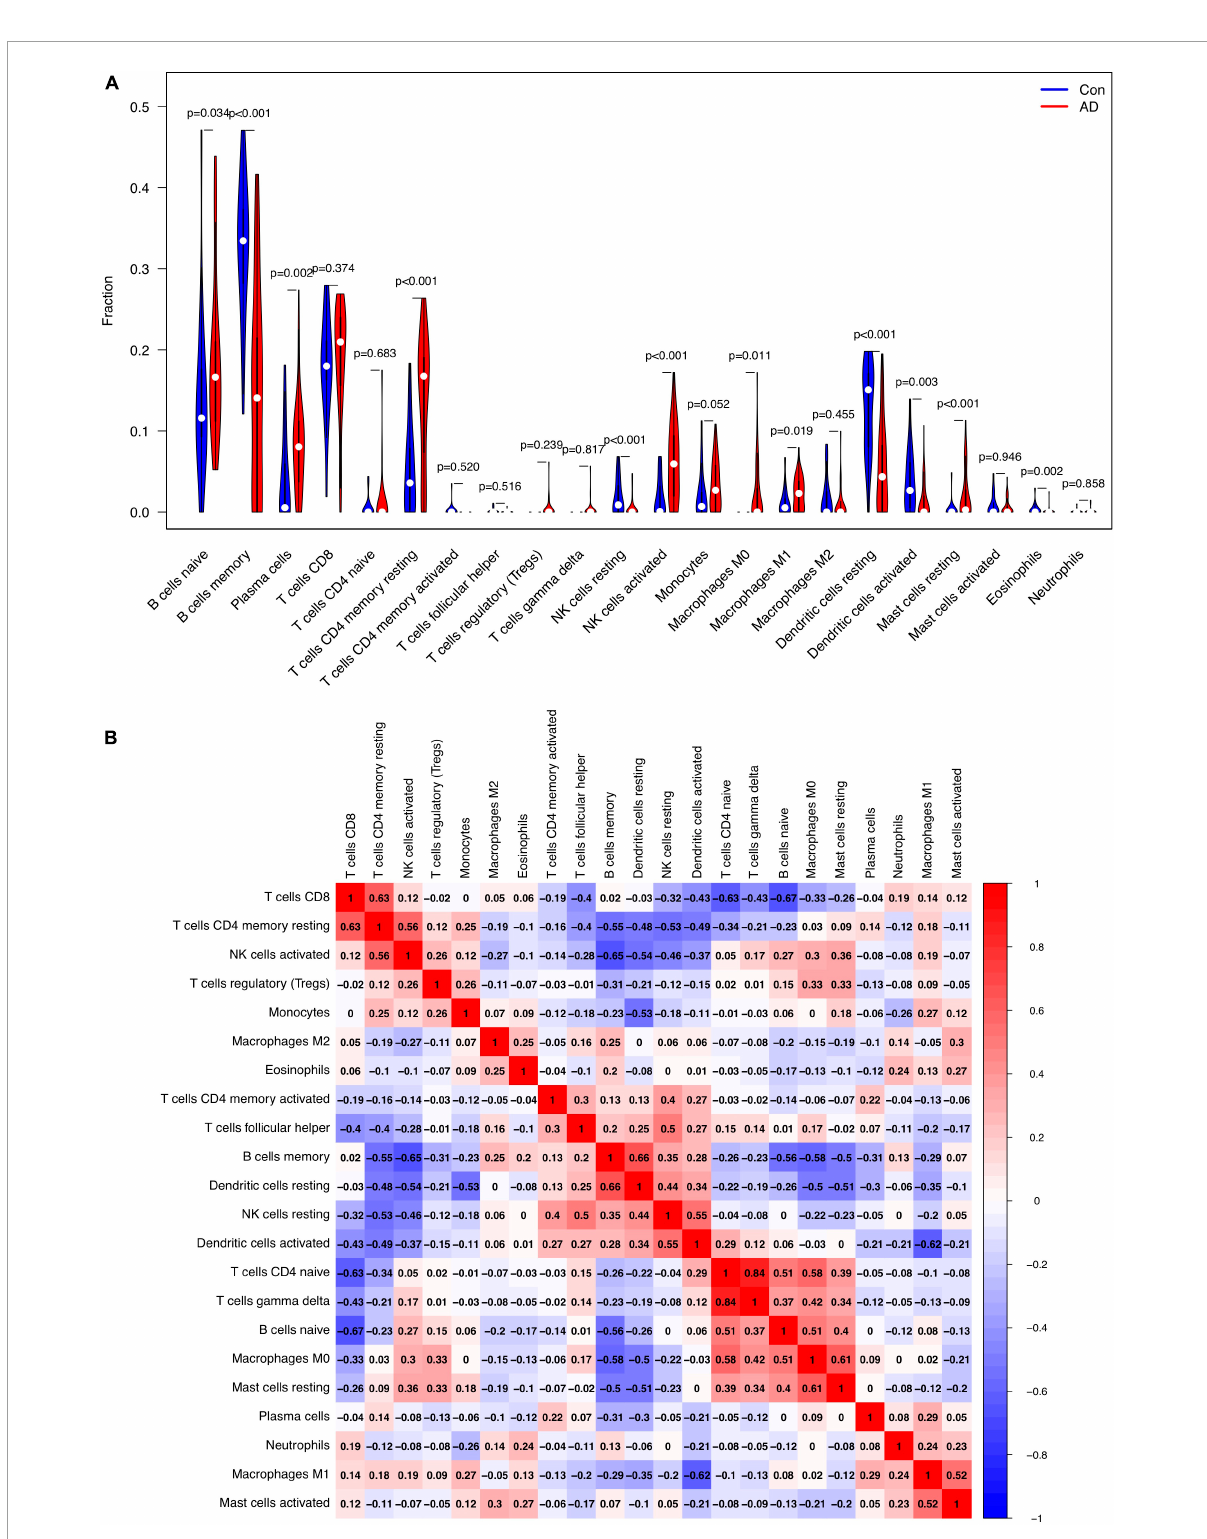
FIGURE7 Comparison and correlation of immune cell infiltration. (A) Comparison of 22 infiltrated immune cell subtypes between Alzheimer’s disease (AD) and control brain tissues. Blue and red colors represent normal and AD samples, respectively. (B) Correlation analysis of these 22 immune cell subtypes